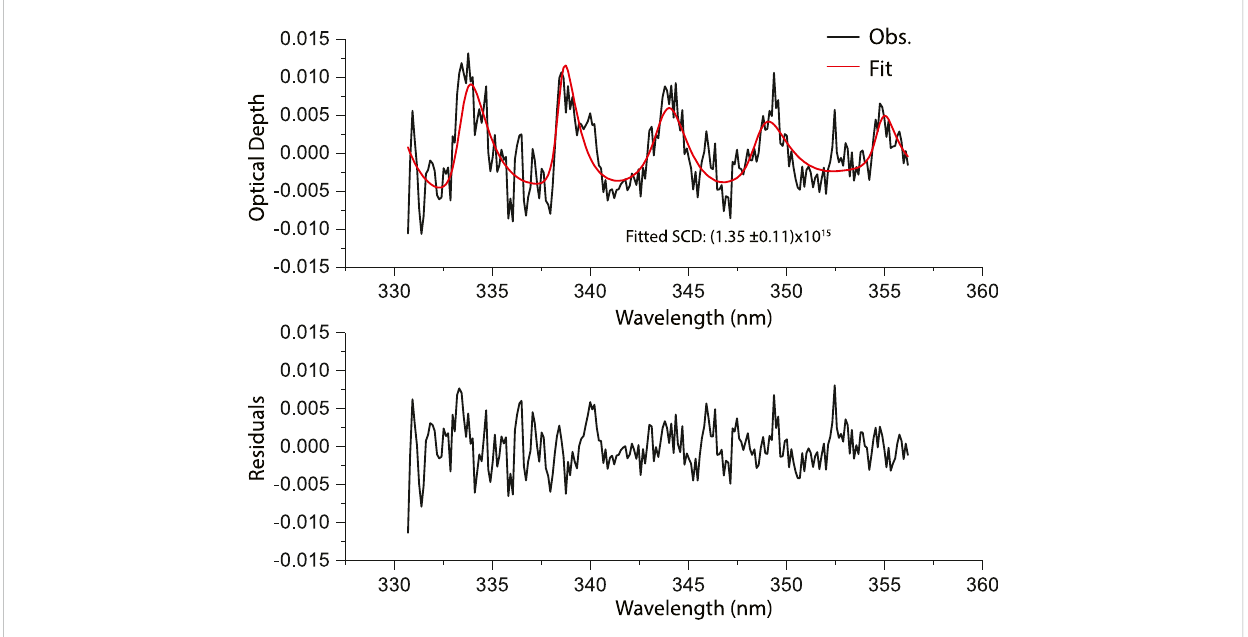
FIGURE 3 Example of fi t of BrO analyzed in the (330.6 – 356.3 nm) spectral window from the DOAS measurements at ALTZ station performed on 20 February 2019. The retrieved slant column density (SCD, in molec/cm 2 ) is shown in the